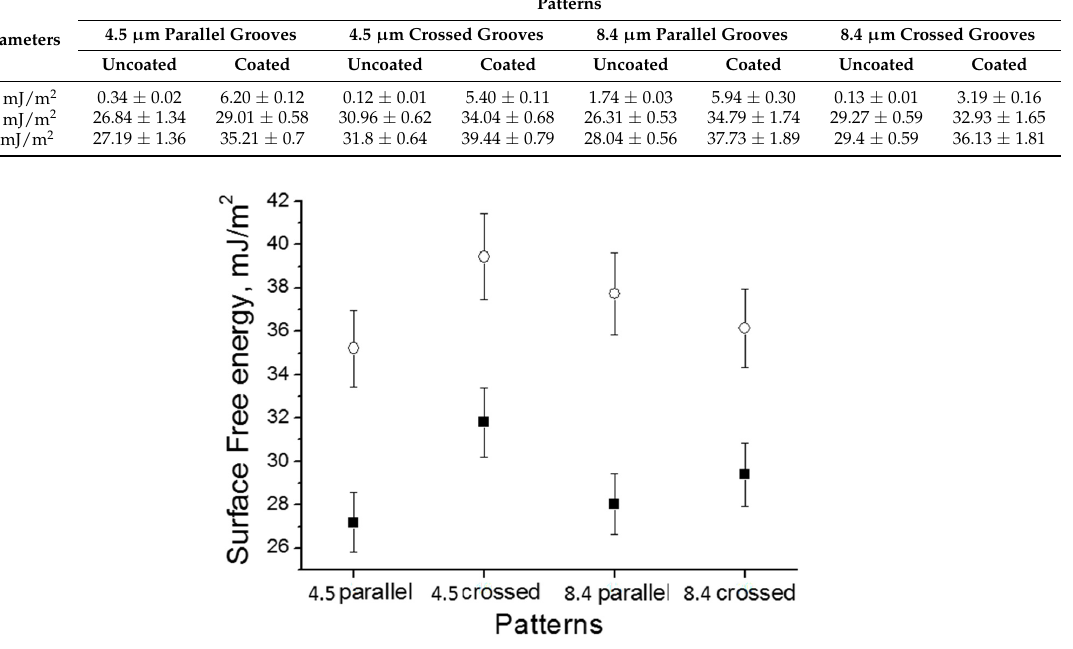
Table 1. The surface wettability parameters of uncoated structured Ti and HA-coated structured Ti. Parameters